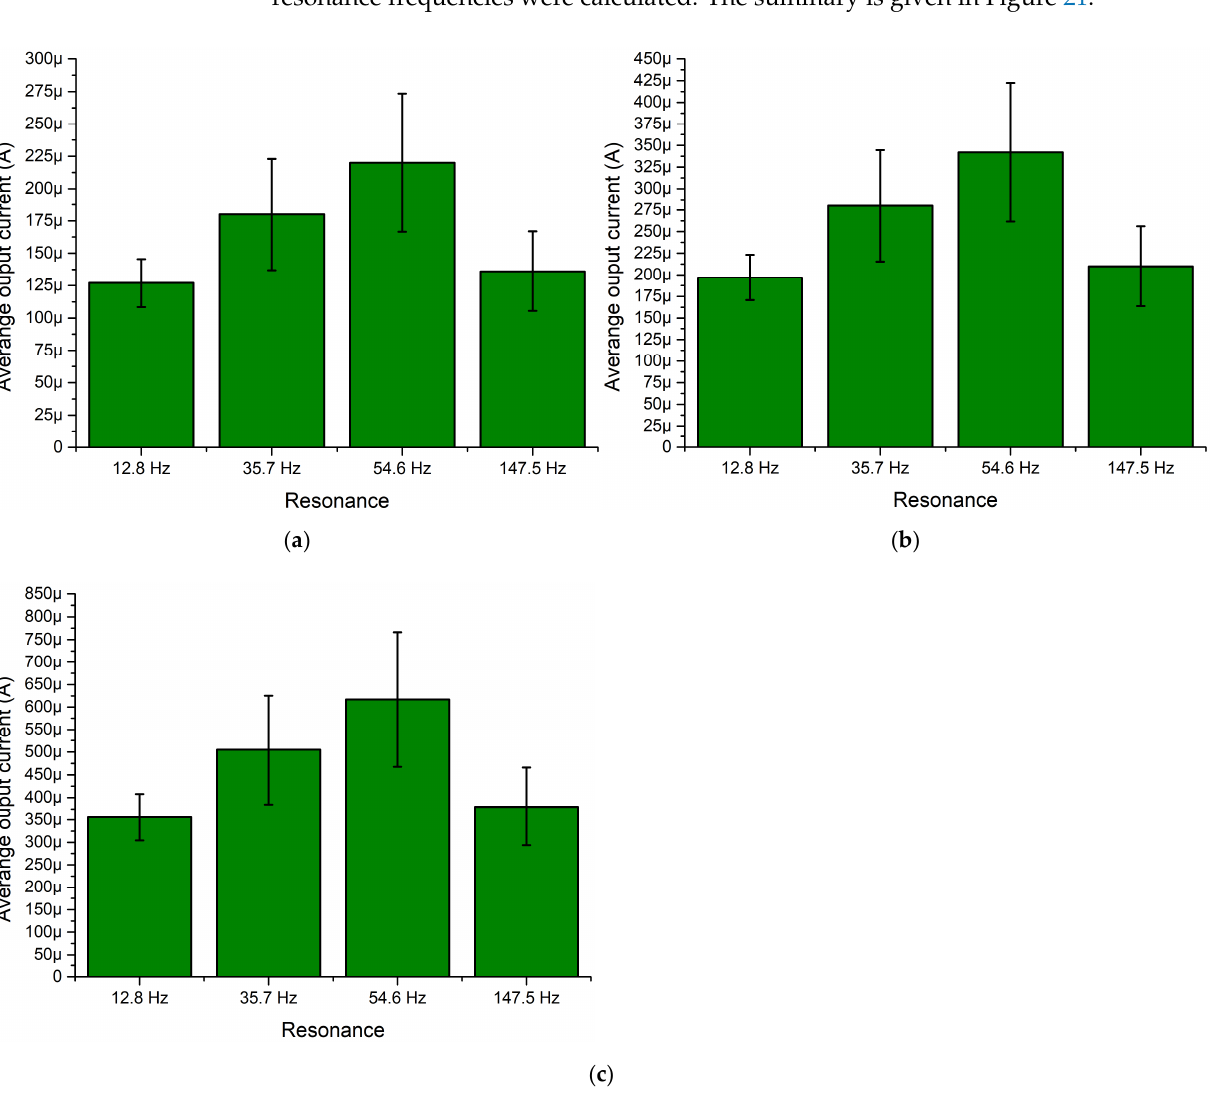
Figure 21. Summary of average output currents at resonance frequencies while different loads are used; ( a )—load equal to 1 MΩ; ( b )—load equal to 500 kΩ; ( c )—load equal to 250 kΩ. used; ( a )—load equal to 1 M Ω ; ( b )—load equal to 500 k Ω ; ( c )—load equal to 250 k Ω